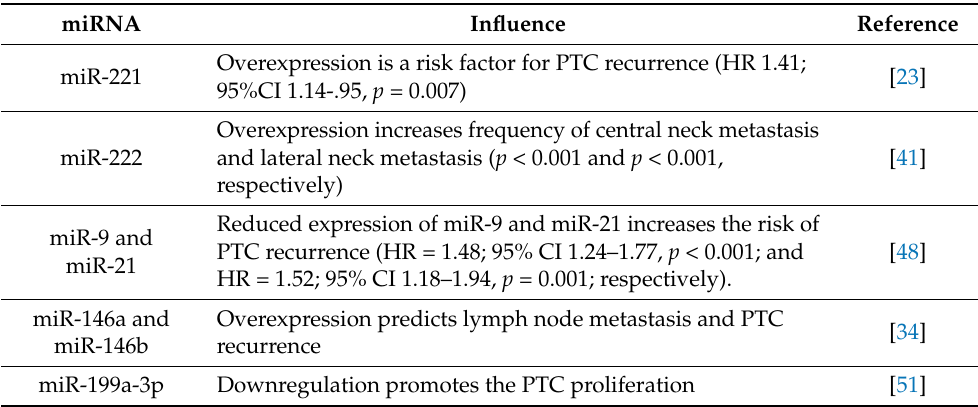
Table 2. Overexpressed and underexpressed miRNAs in PTC tissues. Overexpressed miRNAs Origin of